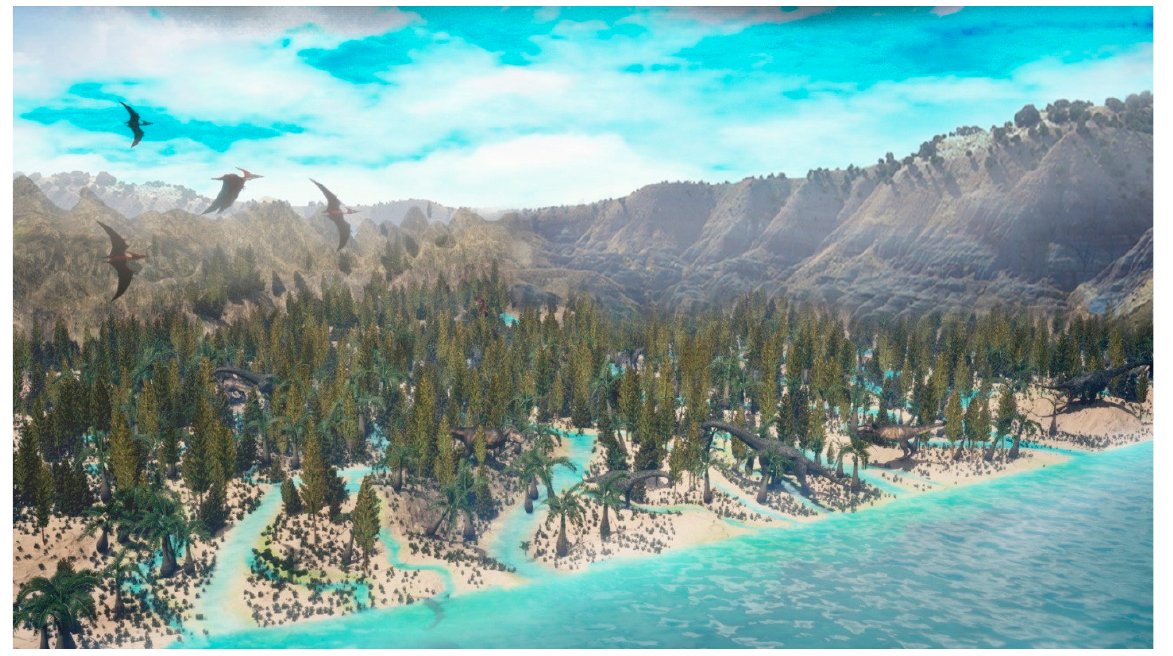
Figure 10. Palaeoreconstruction of “The Jurassic Dinosaur Coast” in the Kimmerdigian-Tithonian of Asturias, taking into account the new palaeobotanical data about the Lastres Fm. (Artist: Jose Luis